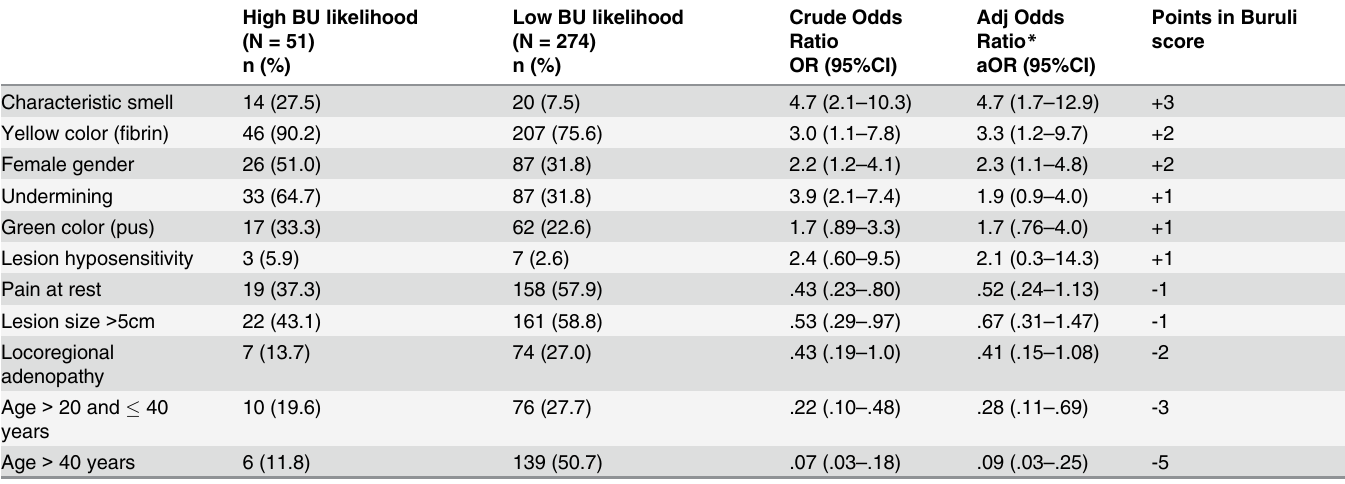
Table 3. Numbers and percentages according to BU likelihood, crude odd ratios, adjusted odds ratios and points attributed in Buruli score of items associated with BU probability. High BU likelihood (N =